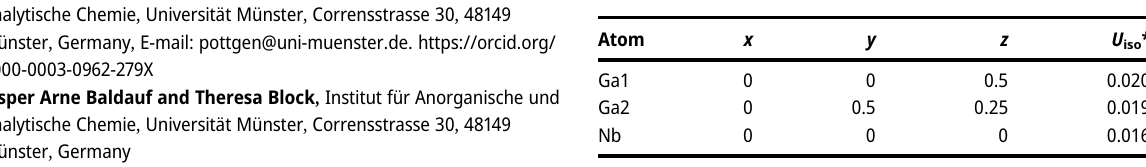
Table  : Fractional atomic coordinates and isotropic or equivalent